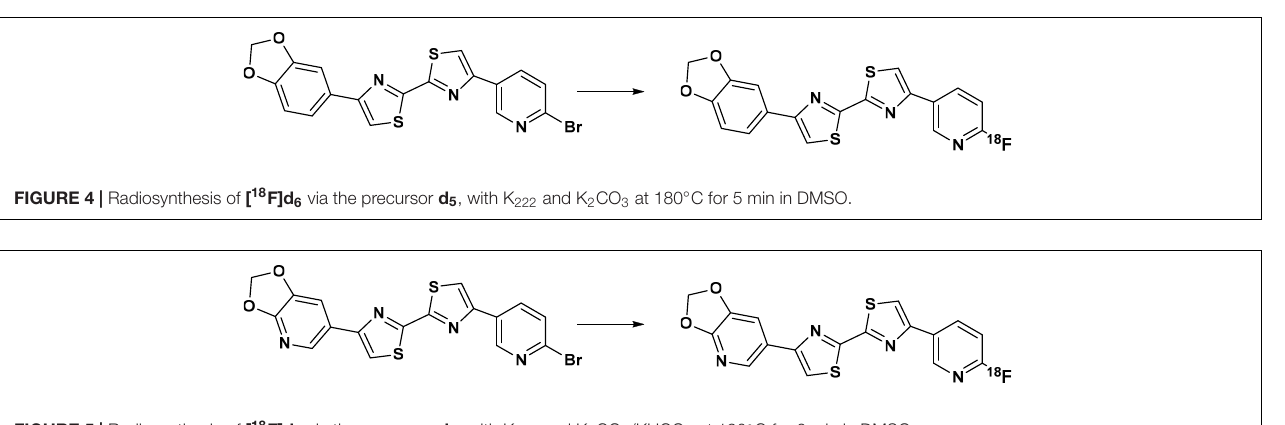
FIGURE 5 | Radiosynthesis of [ 18 F]d 8 via the precursor d 7 , with K 222 and K 2 CO 3 /KHCO 3 at 190 ◦ C for 6 min in